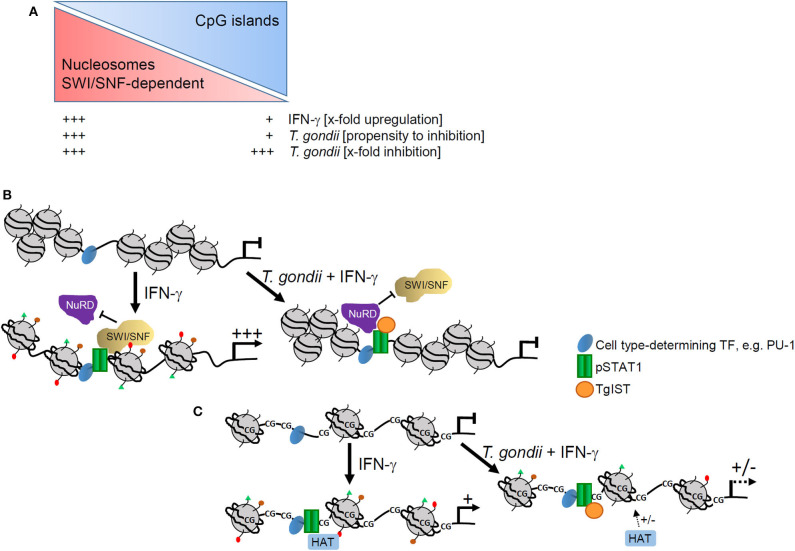
Model of epigenetic control of IFN-γ-induced gene expression by T. gondii. (A) Presence or absence of CpG islands impact magnitude of promoter activation by IFN-γ and propensity of T. gondii to counteract such activation, but it does not generally impact relative levels of parasite-mediated inhibition. (B) CpG-poor promoters are generally densely packed within nucleosomes and their activation by IFN-γ depends on extensive remodeling by SWI/SNF complexes. In T. gondii infected cells, TgIST favors binding of NuRD that is co-recruited together with SWI/SNF and represses promoter activation including nucleosome remodeling and histone modifications. (C) CpG islands within promoters instead favor an open chromatin that does not rely on extensive nucleosome remodeling. Activation of such promoters by IFN-γ requires distinct histone modifications, e.g., acetylation by histone acetyl transferases (HATs). Binding of TgIST to STAT1 in infected cells can abolish histone modifications with limited propensity.